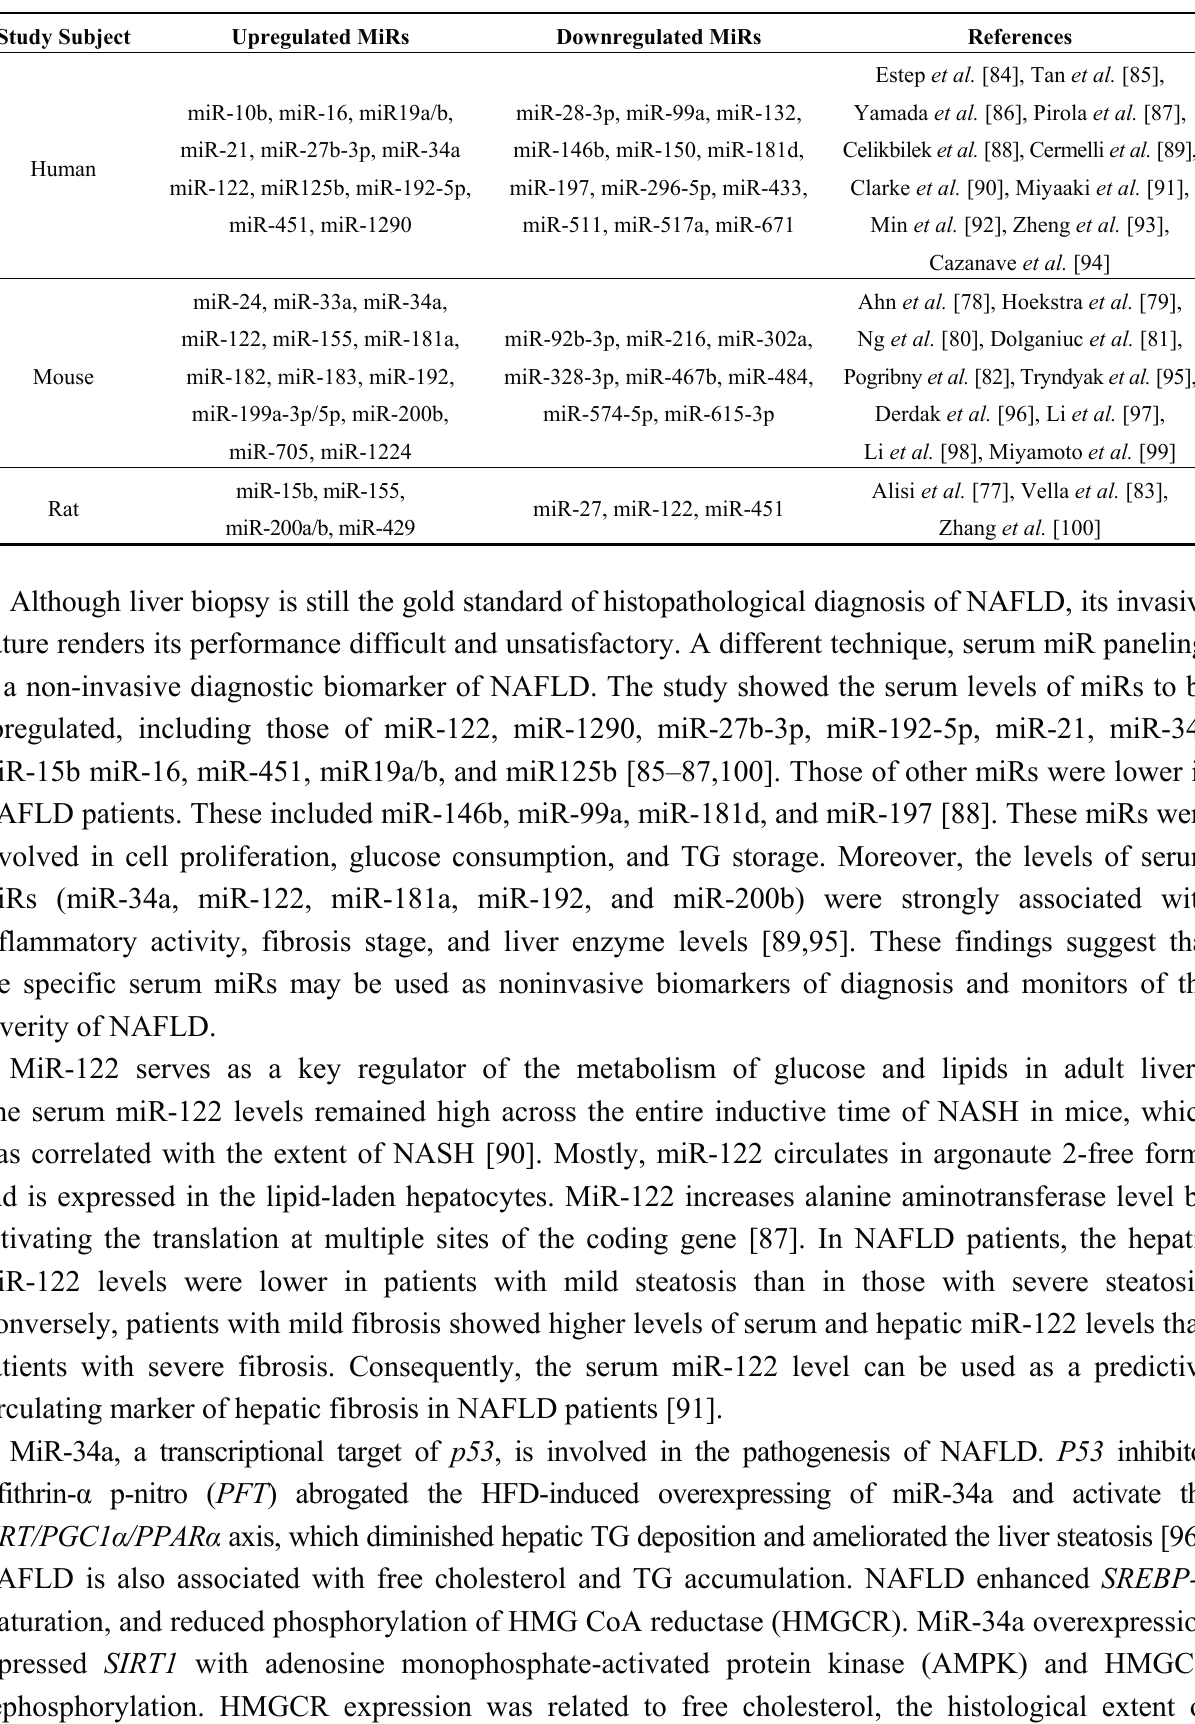
Table 2. MiRs alterations in